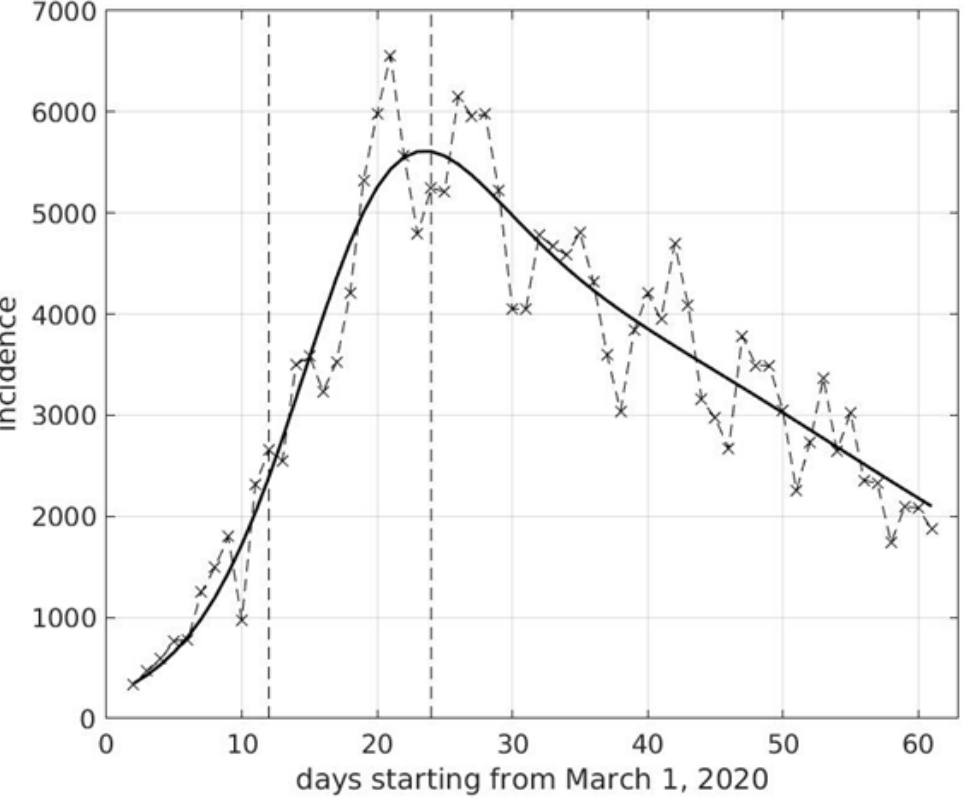
Figure 2. Temporal sequence of SARS-CoV-2 incidence (number of new positive cases per day) in Italy in the period March–April 2020. A fit with a generalization of the logistic model is superimposed to data. The first vertical dashed segment corresponds to March 12, the start of lockdown at national level, while the second one is the day of March 24, when the peak in the estimated incidence curve was reached.